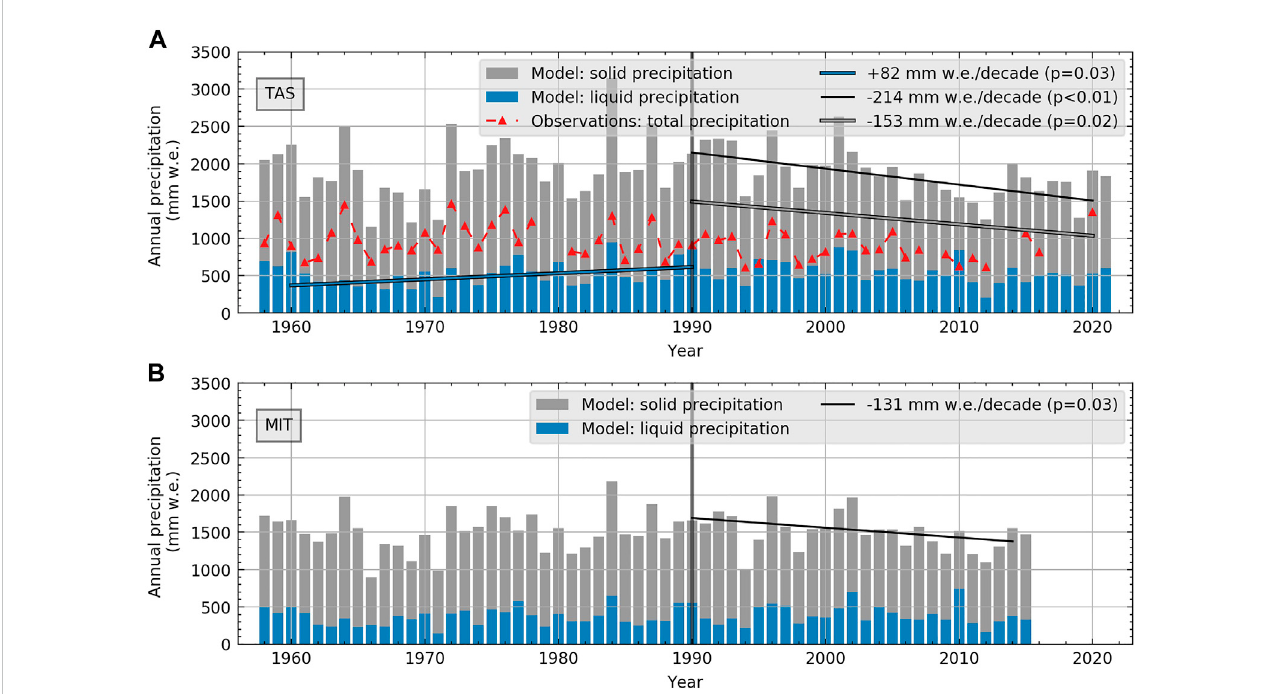
FIGURE 4 Annualliquid(heightofthebluebars),solid(heightofthegreybars)andtotal(topofthestackedbars)fortwolocationsonAmmassalikisland,TAS (A) and MIT (B) . Data from RACMO2 and DMI-TAS. Trends are shown with solid black (for total precipitation), grey with black edges (solid) and blue with black edges (liquid